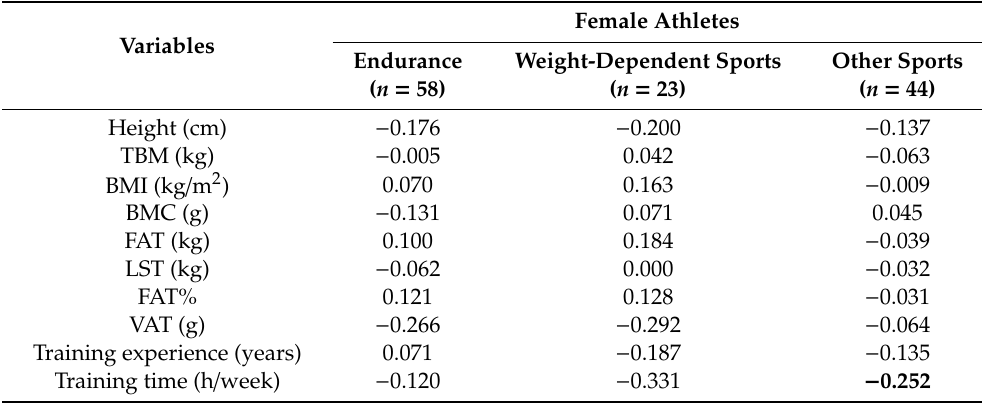
Table 5. Relationship between ORTO-15 score and anthropometric measurements, body composition and training time and experience in female athletes including type of e ff ort.